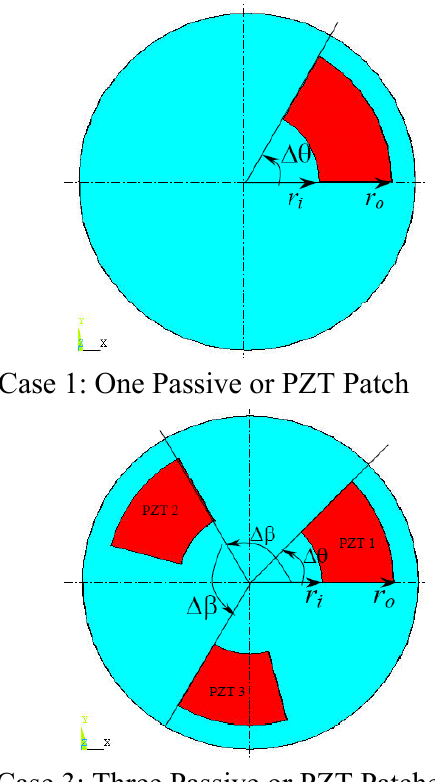
Figure 10. Passive Squeezing Plates for Vibration and Flutter Control (Top